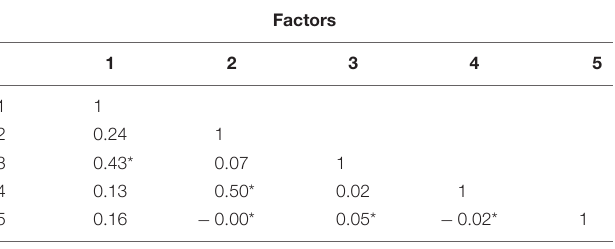
TABLE 4 | Exploratory structural equation modeling (ESEM) factor